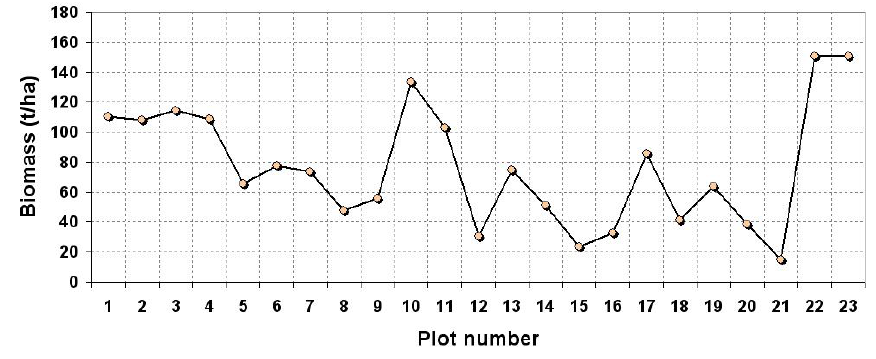
Figure 3. Biomass.